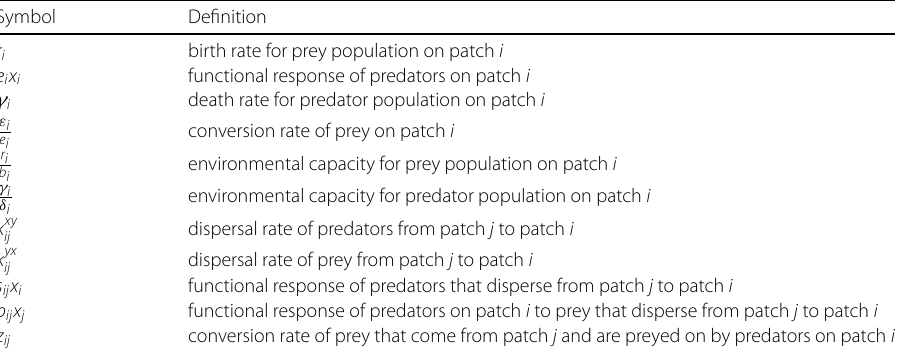
Table 1 Parameters used in the new